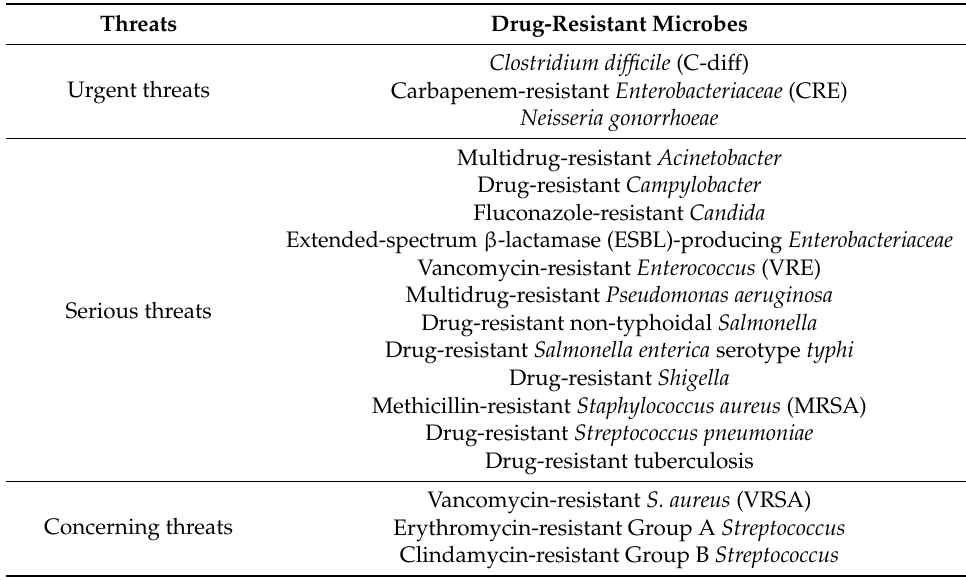
Table 1. The antibiotic resistance threats published by the CDC (Centers for Disease Control)